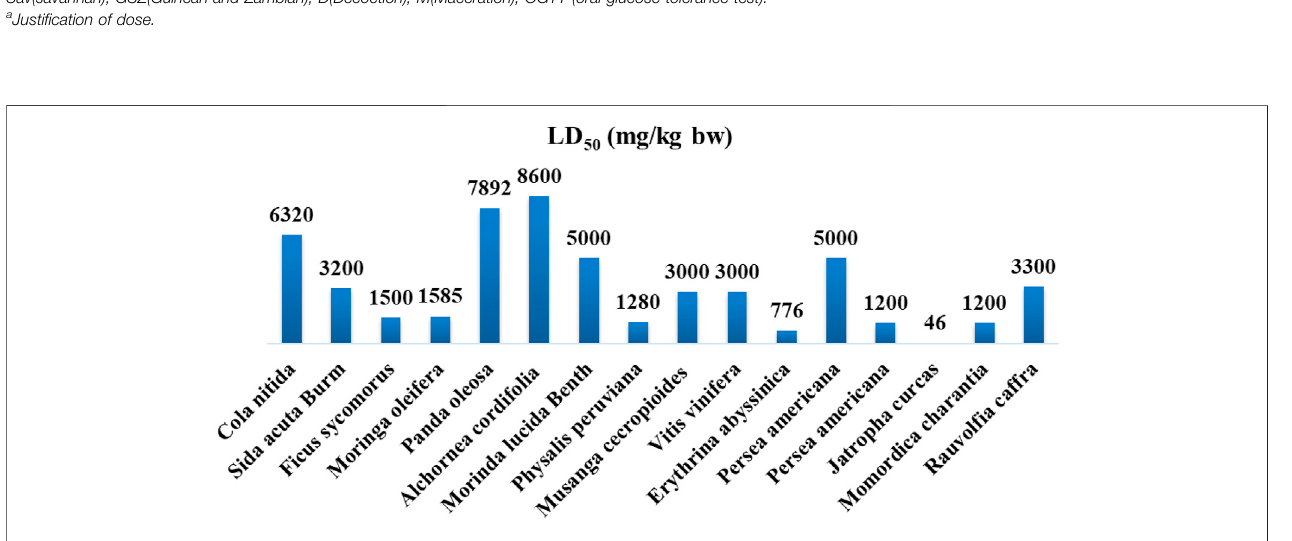
FIGURE 7 | Comparative range of LD 50 for some plants.